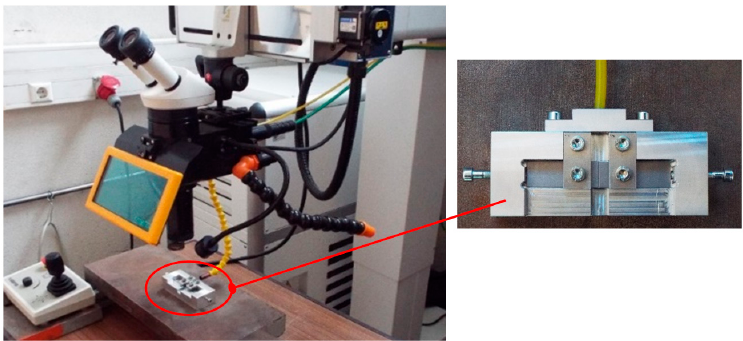
Figure 4. Experimental apparatus of pulsed Nd:YAG laser welding.